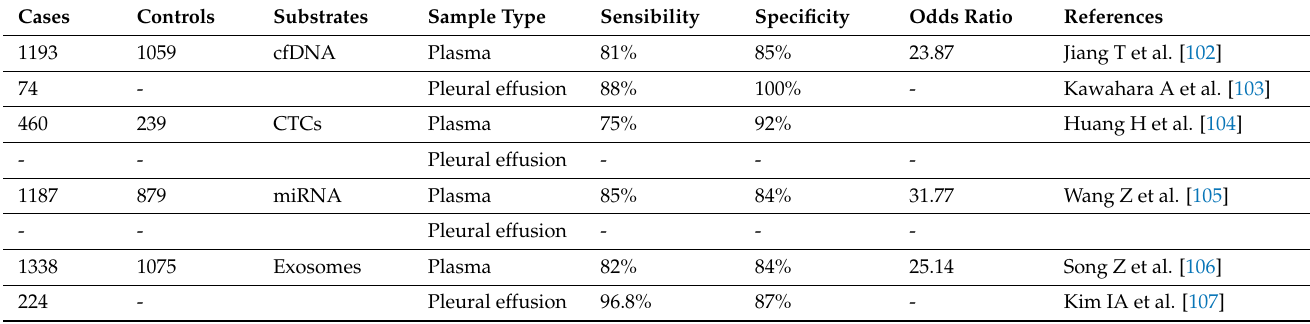
Table 2. Table for evaluating the diagnostic value of single substrates compared between plasma and pleural